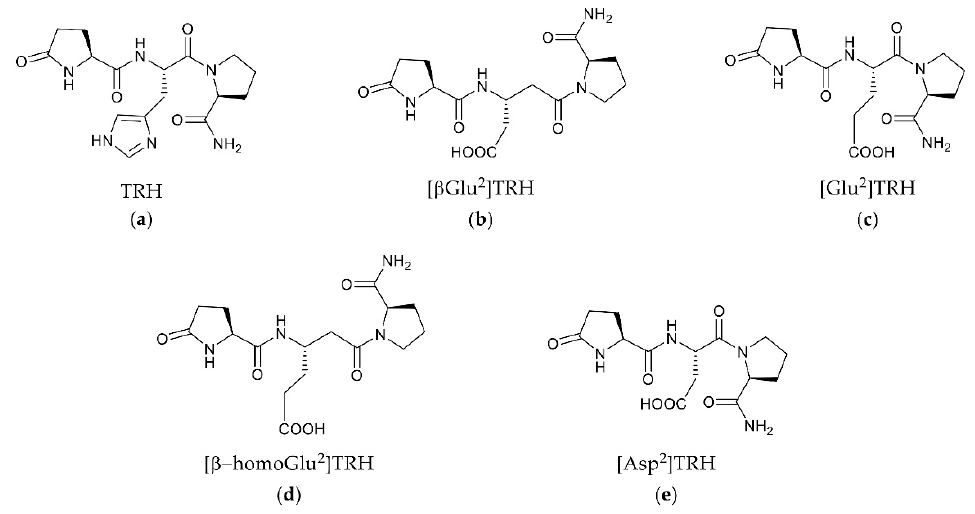
Figure 1. Chemical structures of TRH ( a ) and related pGlu-Xxx-Pro-NH 2 peptides ( b – e ) in which Xxx is a central acidic amino acid residue ( β Glu, Glu, β -homoGlu or Asp), while TRH possesses a basic central residue (Xxx = His).